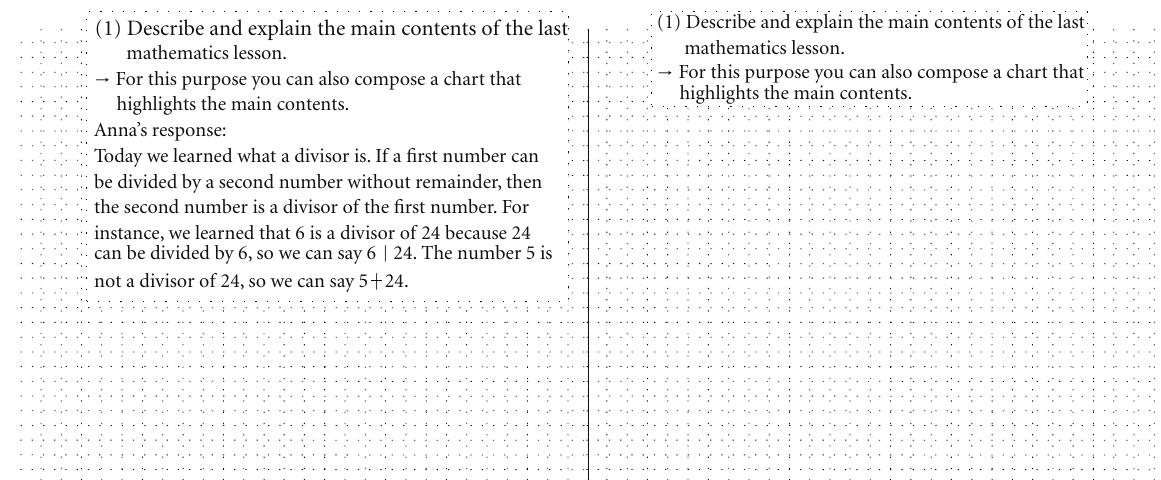
Figure 3: Preprinted learning journal pages with integrated prompt (right side) and solved example problem (left side; translated from